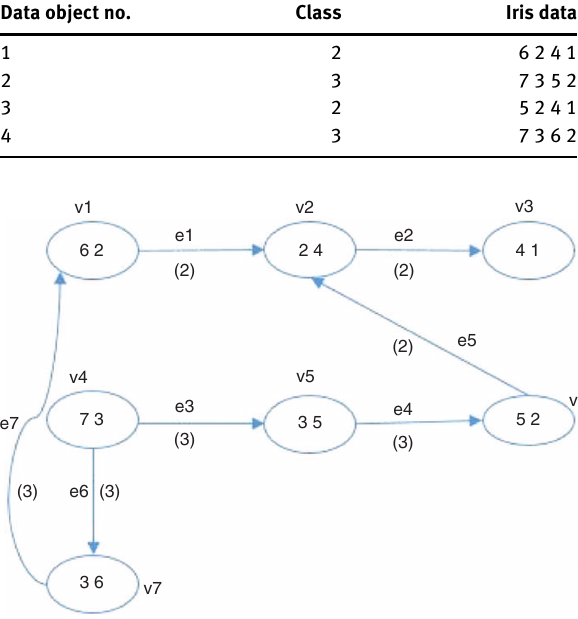
Table 1: Sample Data.